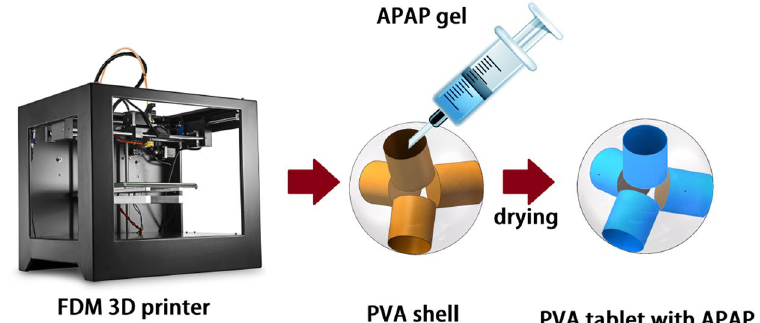
Figure 7. The process of preparing